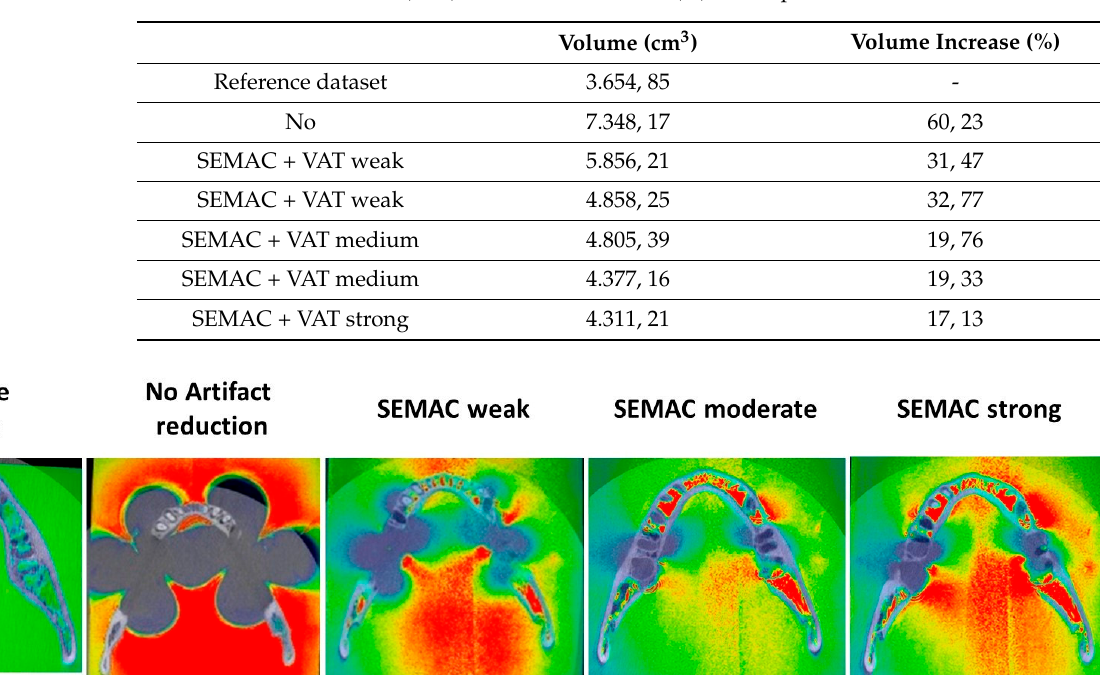
Figure 3. Illustrative comparison among different MRI acquisition modes.